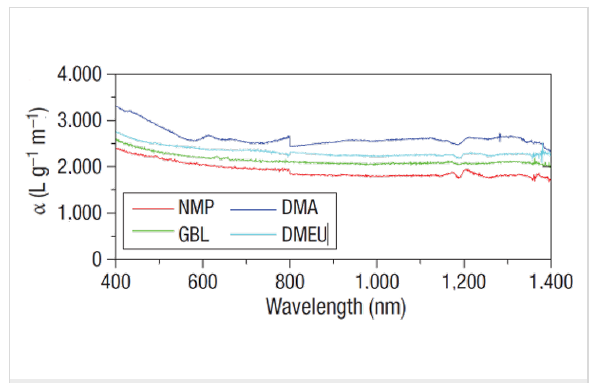
Figure 1: Absorption spectra of graphene layers dispersed in N -methylpyrrolidone (NMP), γ -butyrolactone (GBL), N , N -dimethylacet- amide (DMA) and 1,3-dimethyl-2-imidazolidinone (DMEU) at concen- trations from 2 to 8 µg ∙ mL − 1 . Reprinted with permission from [21], copyright 2008 Nature Publishing